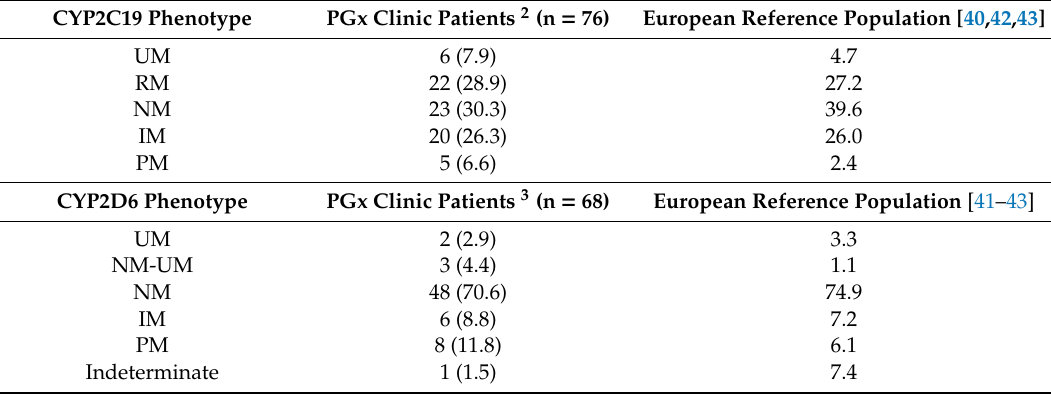
Table 4. Frequency of CYP2C19 and CYP2D6 phenotypes in the pharmacogenetics consult clinic patients compared to a European reference population.